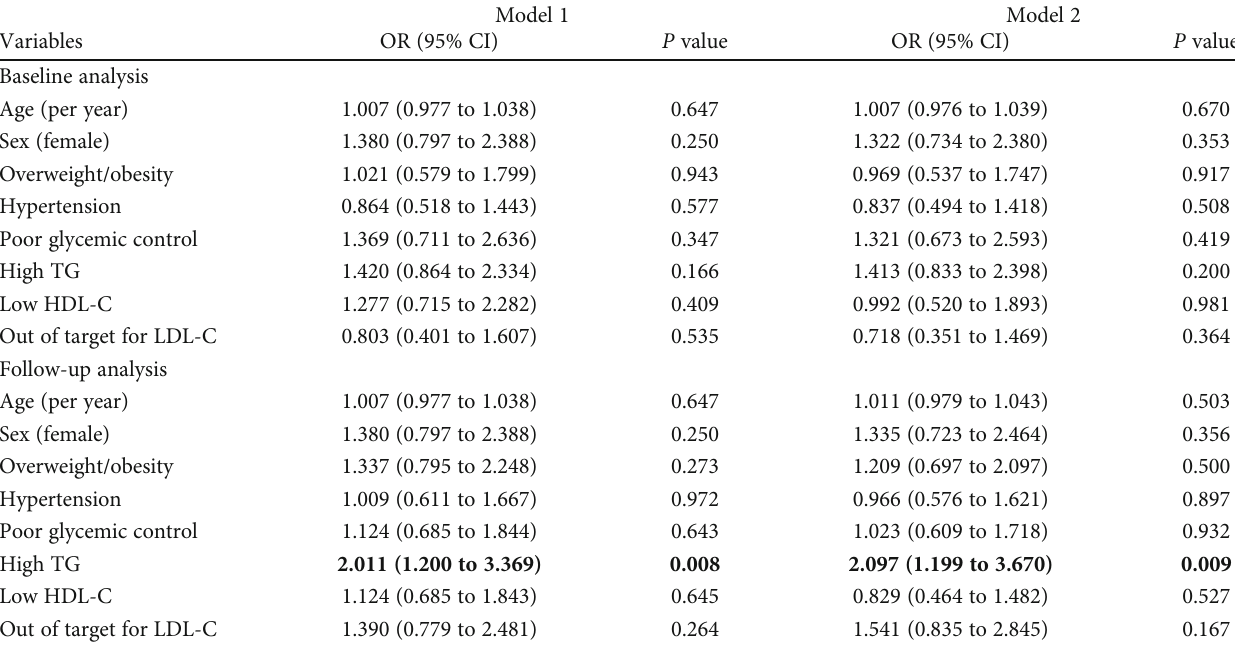
Table 4: The associations of baseline and follow-up metabolic abnormalities with the most reduced eGFR.